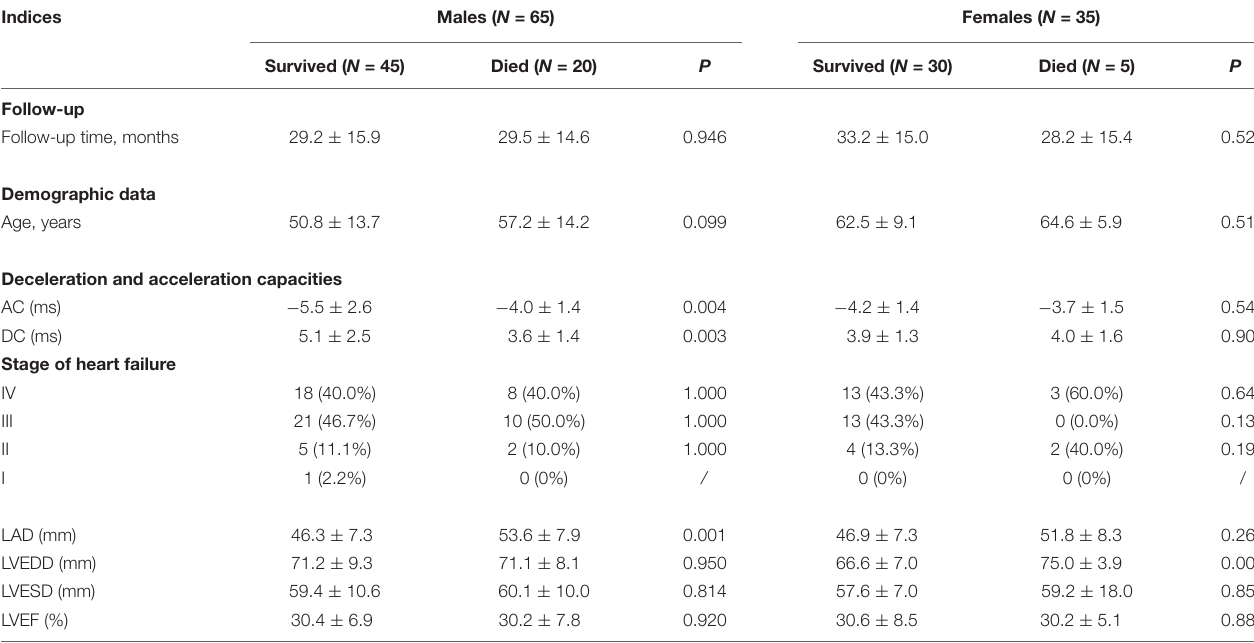
TABLE 4 | Differences between DCM subgroups of those who survived or